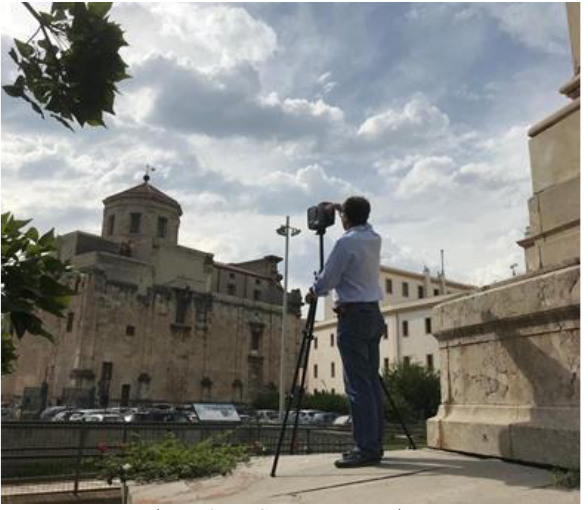
Figure 3. TLS survey operations.